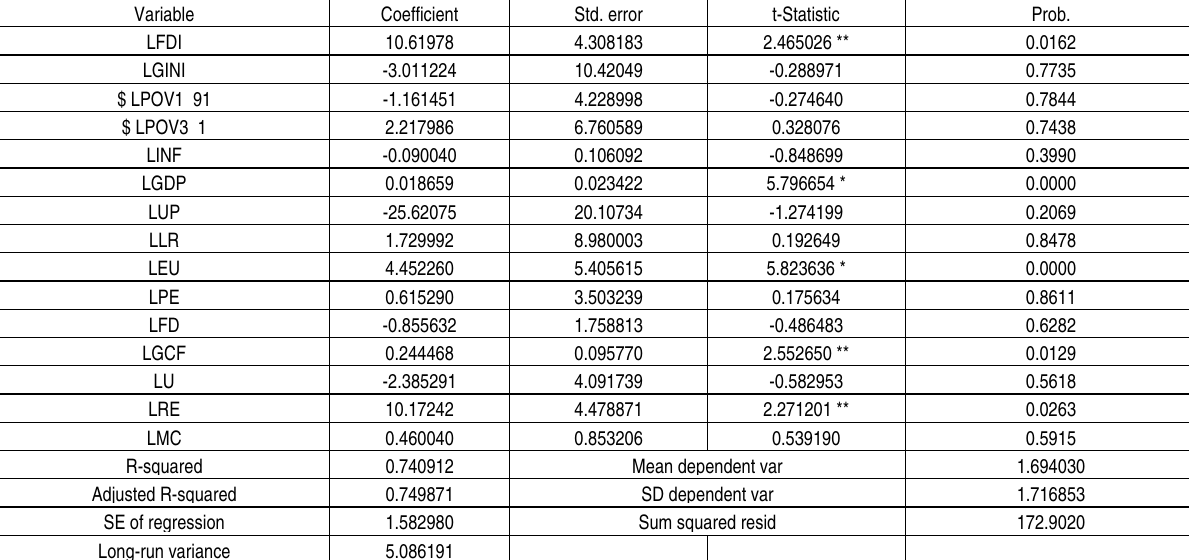
Table 8. FMOLS estimation for variable LCO2